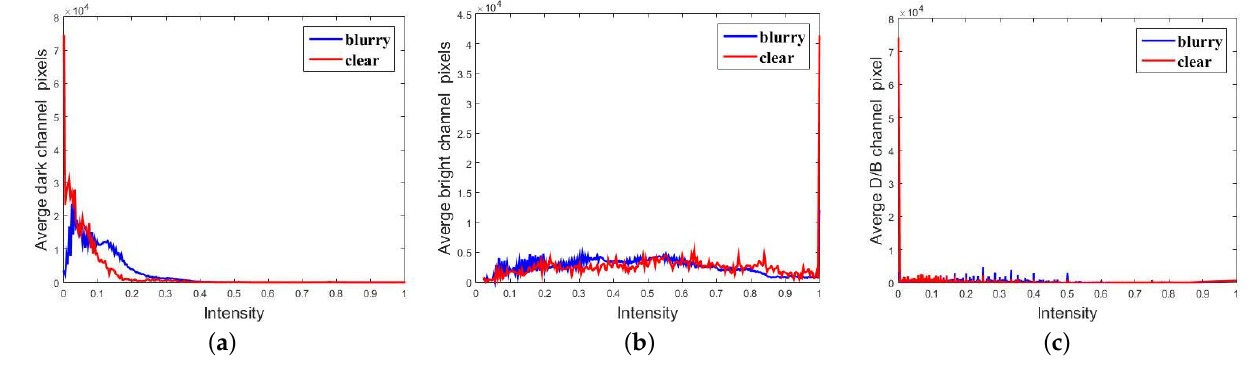
Figure 1. The statistics of the DCP, the BCP and our proposed D/B prior: ( a – c ) average channel pixels distribution of bright, dark and our D/B,